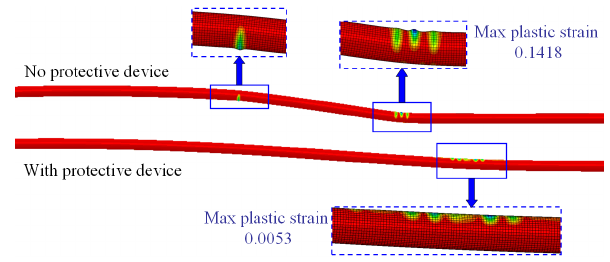
Figure 16. Buckling behaviors of the buried pressure pipeline in two